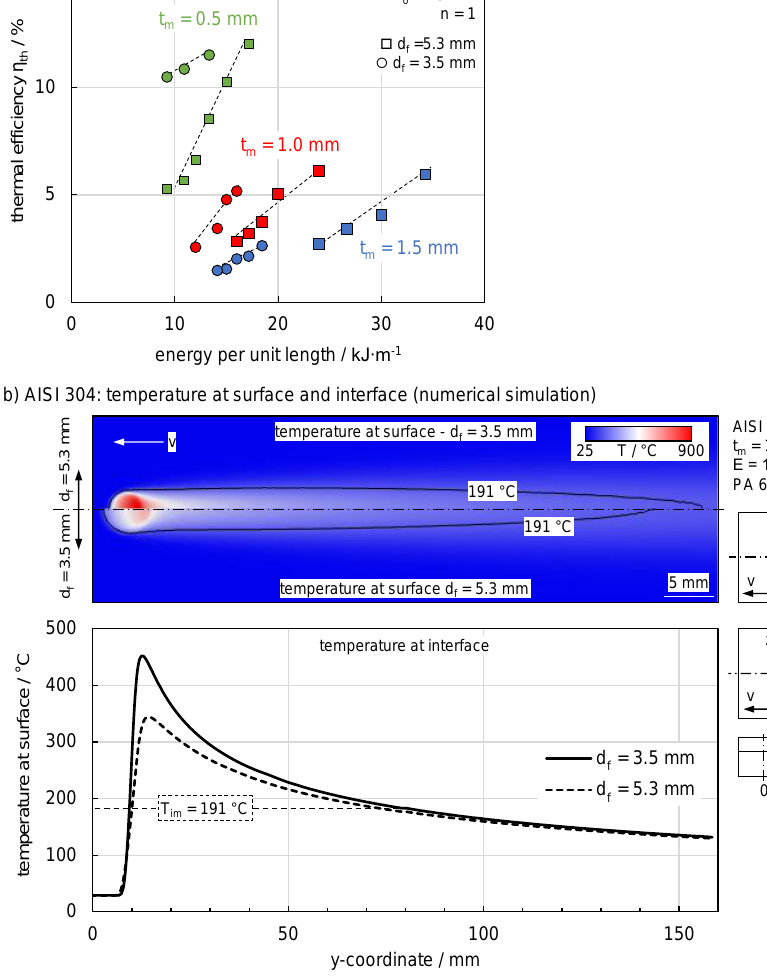
Figure 6. ( a ) Thermal efficiency depending on energy per unit length under varying sheet thickness and focal diameter for the high alloyed steel AISI 304 and ( b ) temperature distribution at the surface and in the interface for different focal diameters based on numercial simulations. The process windows of lower sheet thicknesses shifted to lower energies per unit length as with AA 6082 (Figure 6a). However, the influence of the focal diameter is different compared to AA 6082, i.e., with a smaller focal diameter, comparable thermal efficiencies were achieved at lower energies per unit length. The reason for this behaviour is based on the different characteristics of the temperature field compared to AA6082. Figure 6b shows an overhead view of the simulated temperature field on the metal surface. The temperature field is represented by the isotherm T im at 191 °C as the polymer begins to melt above this temperature. The width of the temperature field is comparable for both spot sizes despite a significantly higher maximum temperature of the smaller focal diameter due to the low thermal diffusivity and thermal conductivity of AISI 304. The increased